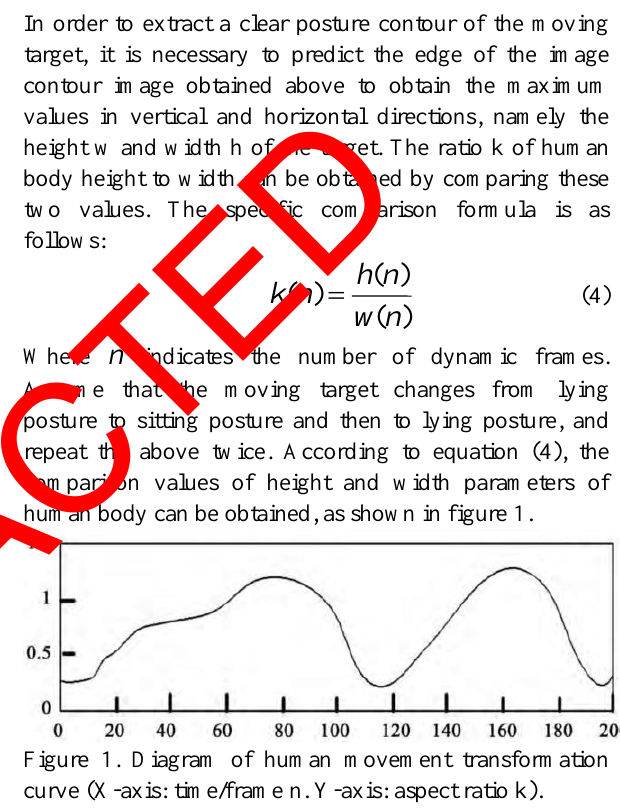
Figure 1. Diagram of human movement transformation curve (X-axis: time/frame n. Y-axis: aspect ratio